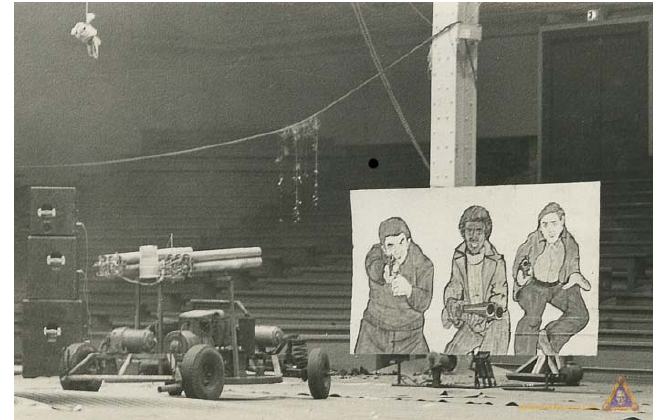
Figure 4. Scene from Terrifying Scenes from The Battlefields of Tomorrow , a mechanical performance by SRL, 6 December 1980, Kezar Pavillion, San Francisco. © Survival Research Labs.